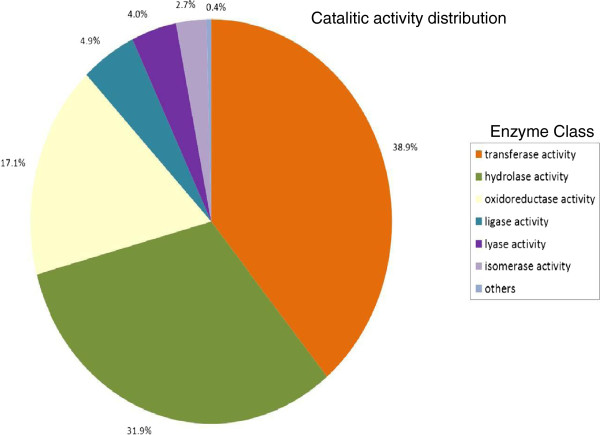
Catalytic activity distribution in annotated
P. alba
unigenes.